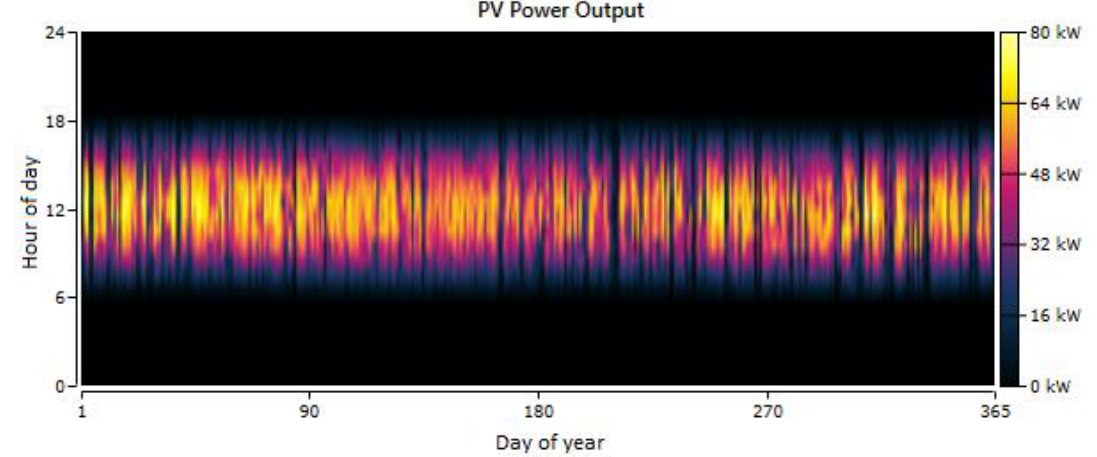
Figure 13. The PV array output.